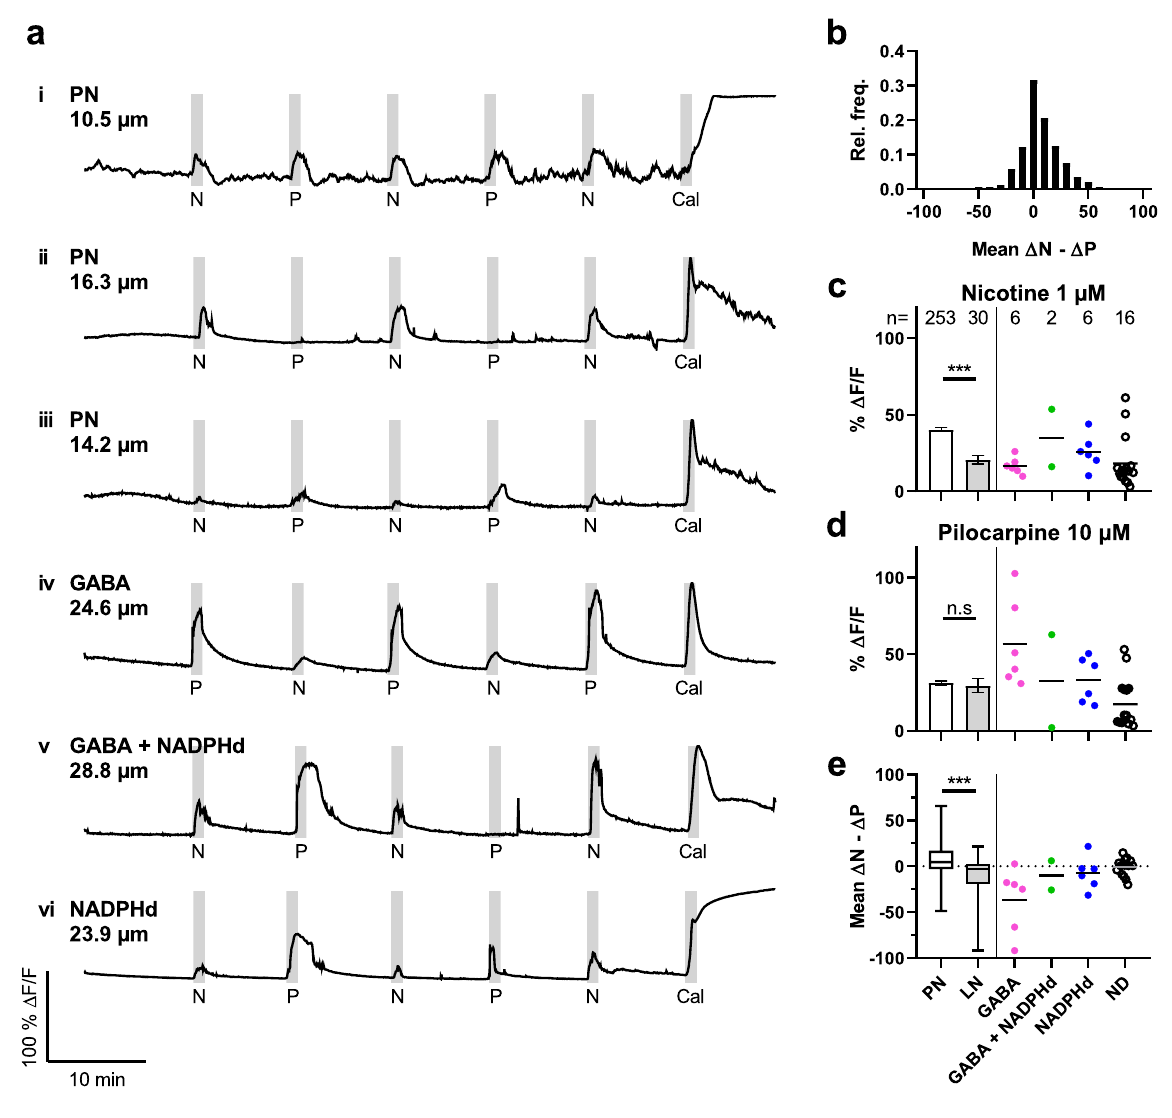
Figure 5. Nicotine and pilocarpine induced-Ca 2+ transients of cultured antennal lobe neurons. Representative Ca 2+ signals of PN ( i – iii ) and LN ( iv – vi ) are shown in a . Stimulations are shown as vertical gray band, with the width representing the duration of the stimulus. PNs show three response types (equal i ; stronger nicotinic ii ; stronger muscarinic iii ). A histogram ( b ) illustrates the distribution of these types as difference in response amplitude, with 31.6% of PN showing equivalent responses. Mean amplitudes (± s.e.m.; normalized to calcimycin) of pooled PN and LN during stimulation with 1 µM nicotine (PN: 40.41 %ΔF/F ± 1.45 s.e.m.; LN: 20.51 %ΔF/F ± 2.69 s.e.m.) or 10 µM pilocarpine (PN: 31.24 %ΔF/F ± 1.27 s.e.m.; LN: 29.38 %ΔF/F ± 4.51 s.e.m.) are depicted in c and d . Colored data points represent subtypes of individual LN. During nicotinic stimulation, Ca 2+ transients of PN were significantly larger than those of LN ( p < 0.0001, Mann–Whitney test). When stimulated with pilocarpine no significant differences between PNs and LN were observed ( p = 0.3825, Mann– Whitney test). Amplitude difference between nicotine and pilocarpine induced responses (ΔN—ΔP; e ) is used to quantify the relationship between nicotinic and muscarinic responses in individual neurons (PN: 6.84 %ΔF/F ± 1.13 s.e.m.; LN: -9.77 %ΔF/F ± 4.17 s.e.m.). LN show a significant difference to PNs ( p < 0.0001, Mann–Whitney test). Cal = Calcimycin; N = Nicotine; P =